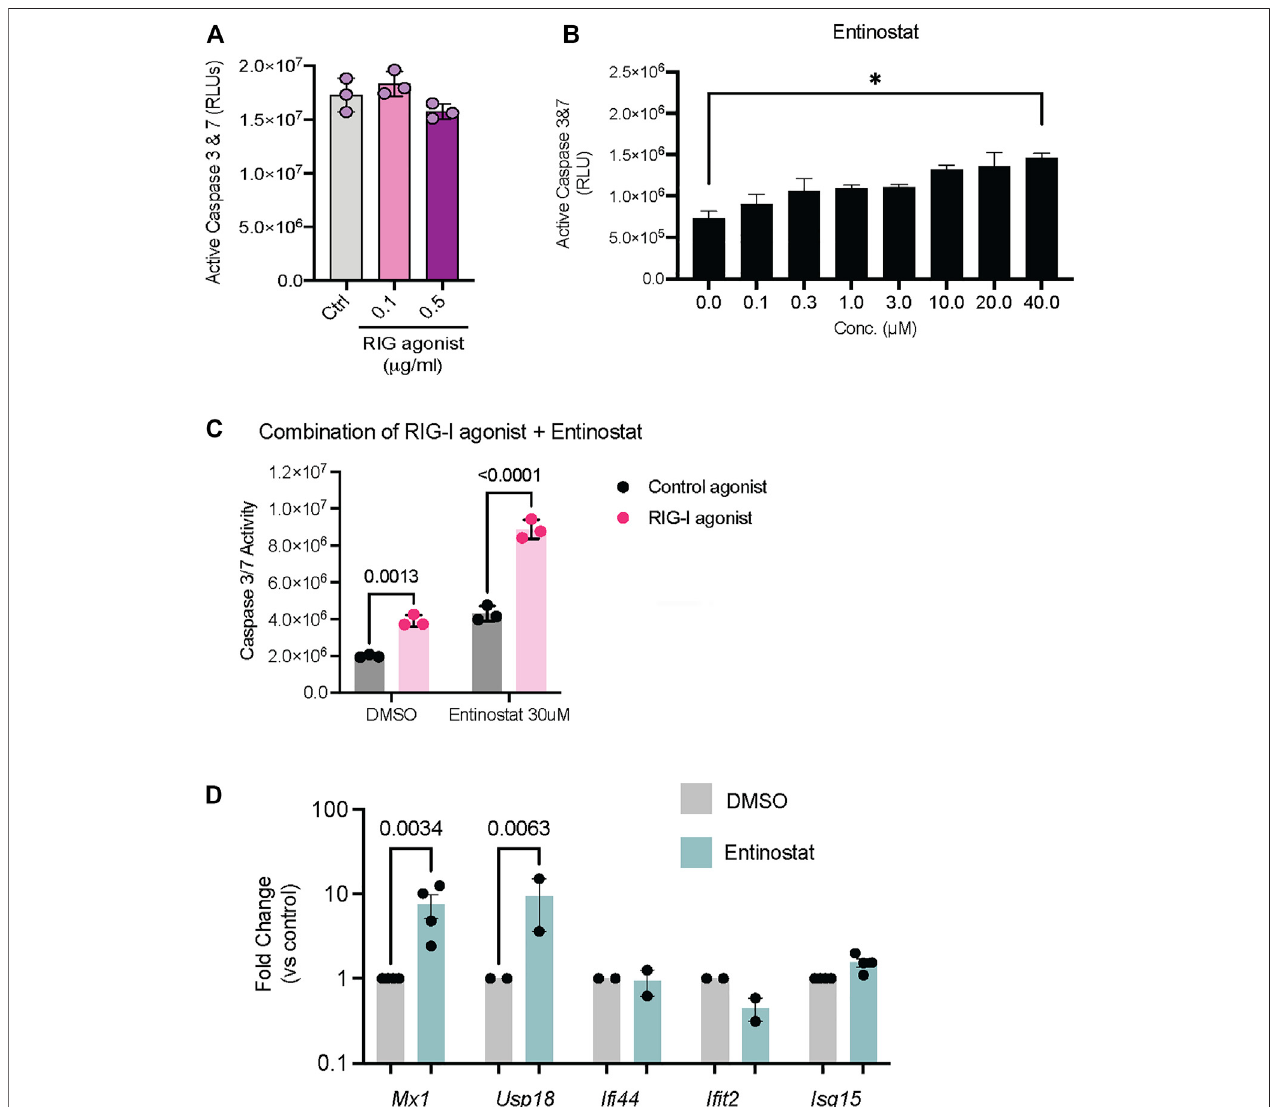
FIGURE 4 | Activation of RIG-I signaling in tumor cell lines in response to HDAC and PLK inhibitors. (A) 4T1 mammary carcinoma cells were treated with RIG-I agonist alone or (B) Entinostat alone or (C) RIG-I agonist at 0.5 ug/ml followed by Entinostat at the indicated concentration. 24 h later cell death was measured by